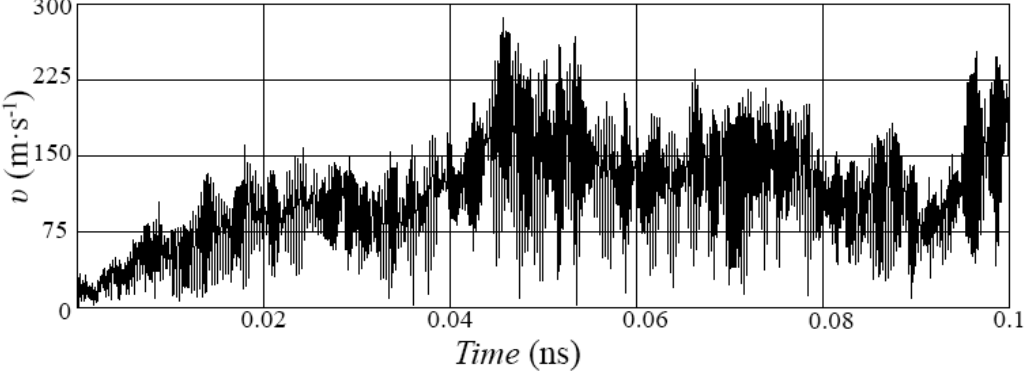
Figure 10. Translational velocity of the C 60 .